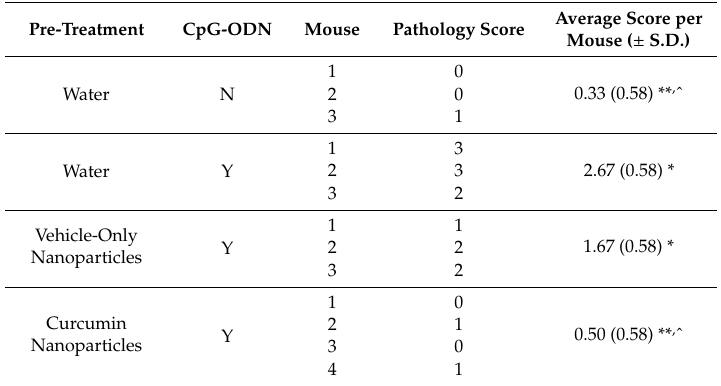
Table 2. Scores of tissue inflammation following intravaginal delivery of curcumin-loaded nanoparticles prior to inoculation with CpG-ODN.